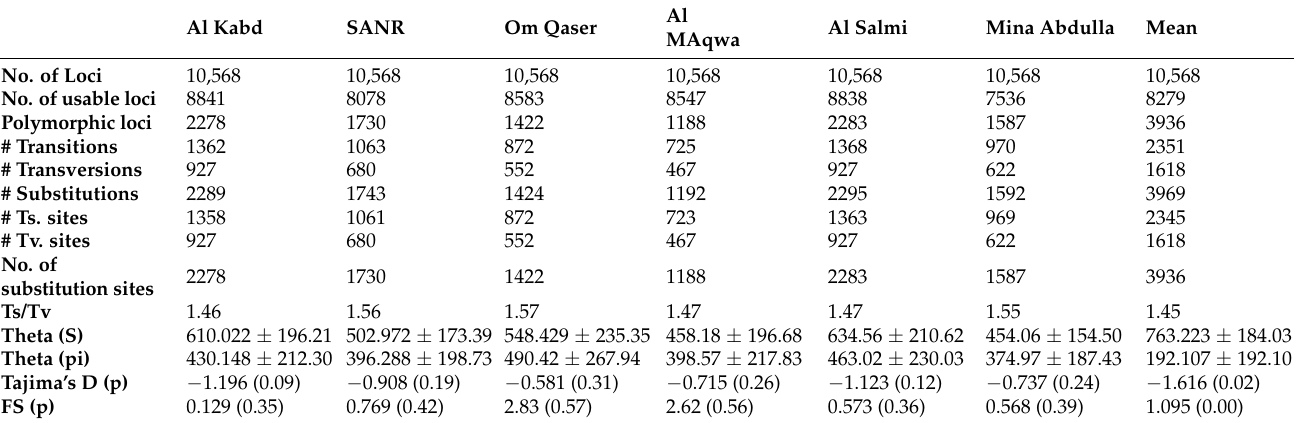
Table 1. A summary of SNPs, indels, transitions and transversions in 98 genotypes of R. eppaposum.